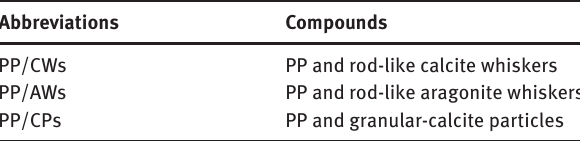
Table 1: Abbreviation and composition of the studied